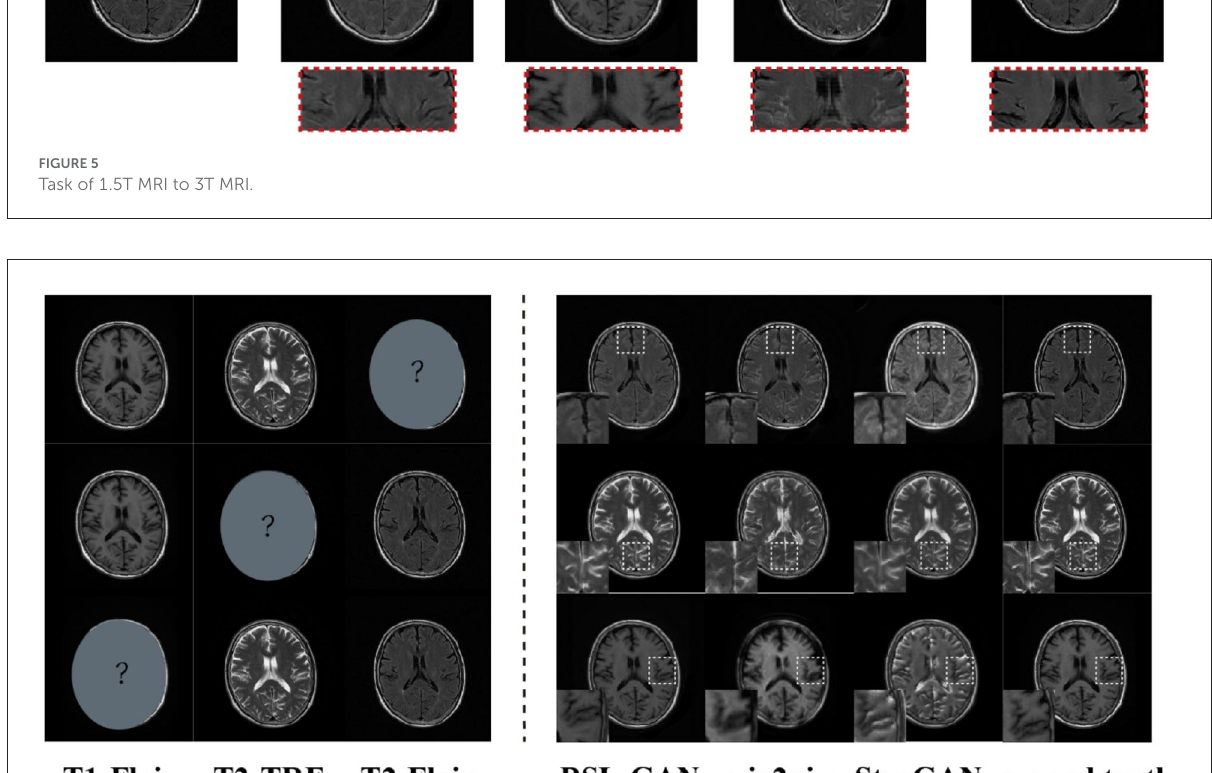
FIGURE6 Images synthesized via missing modal data and the experimental results of other